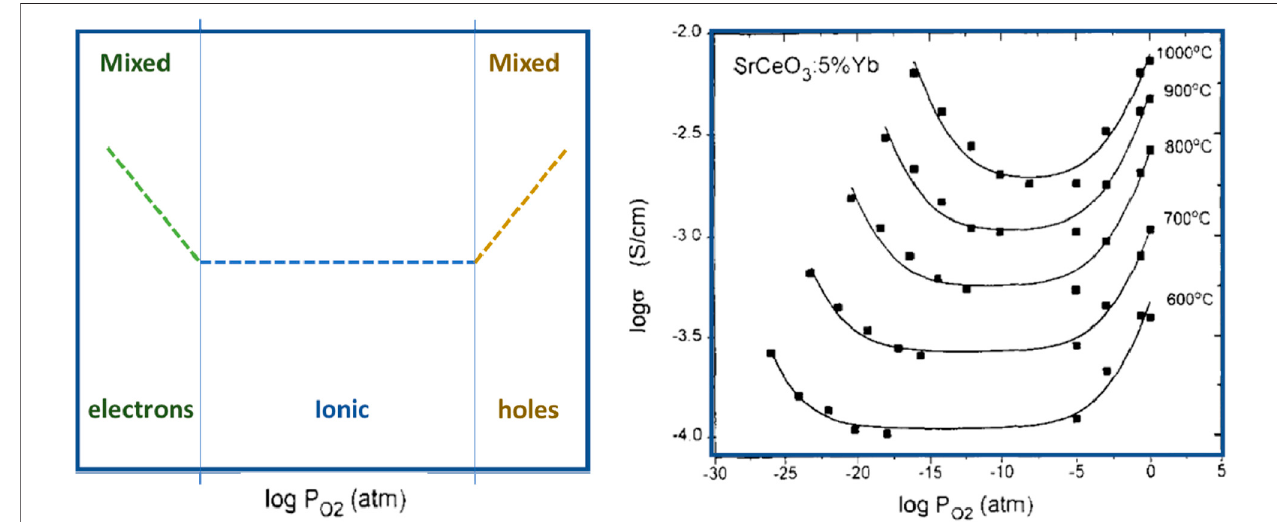
FIGURE2 | Schematic ofConductivitybehavioras function ofpO 2 (LHS), Experimental Data from reference (RHS) showing electrical conductivity ofSrCeO:5%Yb vs. pO 2 . ( Figure adapted from Reference 16 with permission from Elsevier